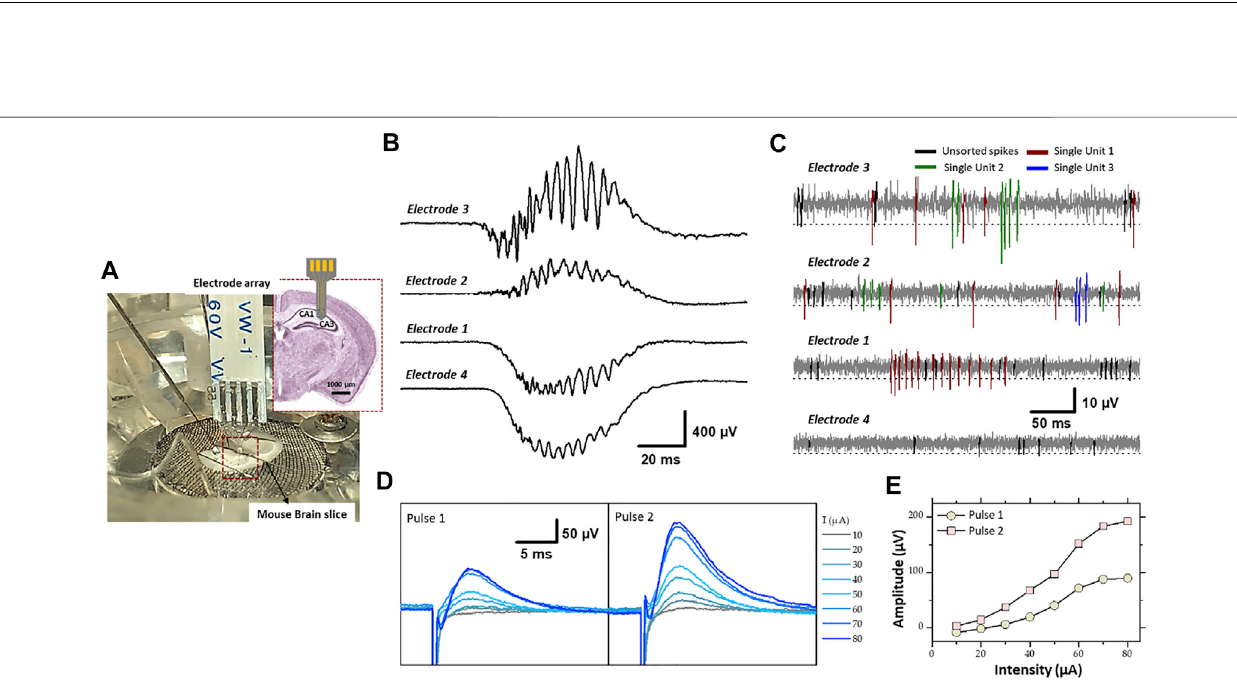
The other type of spontaneous activity that was recorded in the hippocampus corresponds to action potentials APs (spikes) generated by neurons (Buzsáki 2015; Obien et al., 2015). They